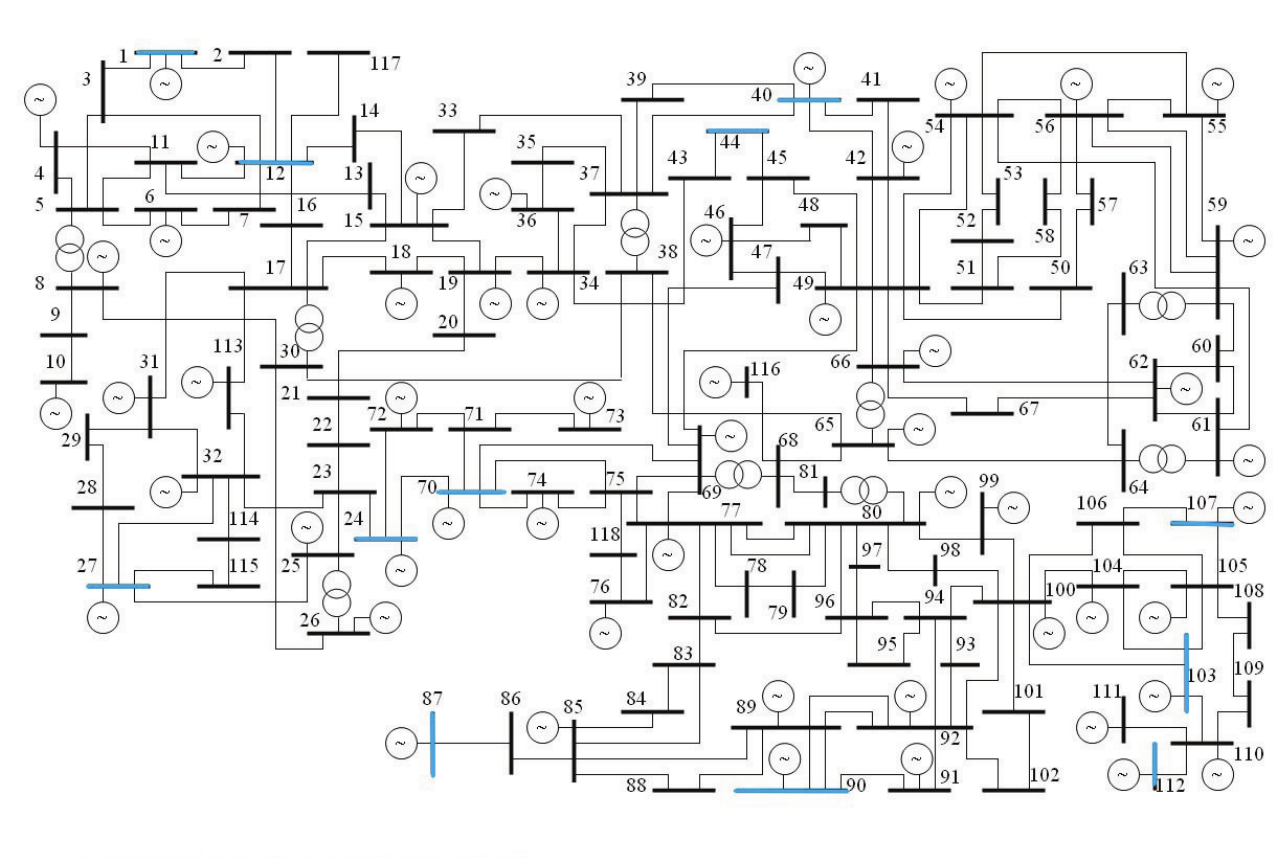
Figure 4. EEE 118-bus test system; blue buses indicate the added wind generation location